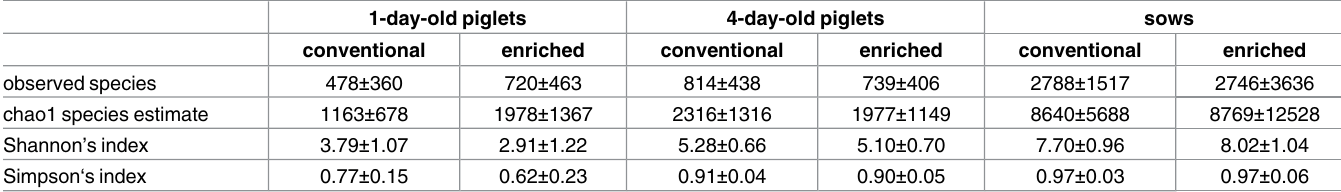
Table 1. Basic diversity characteristics of microbiota present in feces of each category of pigs analyzed in this study. 1-day-old